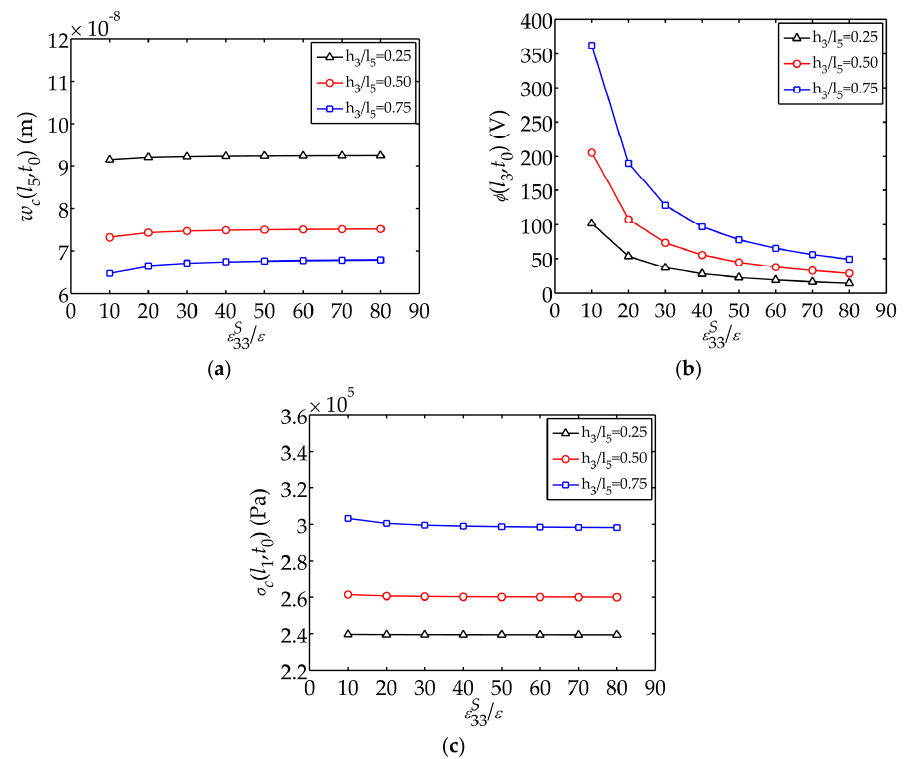
Figure 8. Displacement w c ( l 5 , (cid:1872) (cid:2868) ), electric potential ϕ ( l 3 , (cid:1872) (cid:2868) ) and stress (cid:2026) (cid:3030) (l (cid:2869) , (cid:1872) (cid:2868) ) changing with (cid:2013) (cid:2871)(cid:2871)(cid:3020) (cid:2013)⁄ : ( a ) Displacement w c ( l 5 , (cid:1872) (cid:2868) ); ( b ) Electric potential ϕ ( l 3 , (cid:1872) (cid:2868) ); ( c ) Stress (cid:2026) (cid:3030) ( l 1 , (cid:1872) (cid:2868) ).